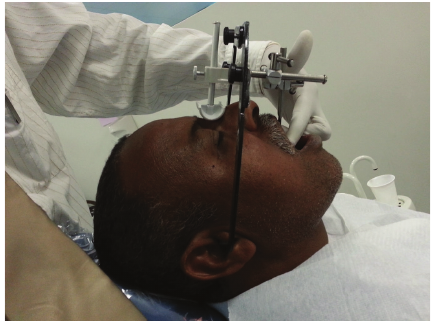
Figure 4: Face bow transfer for mounting working cast.